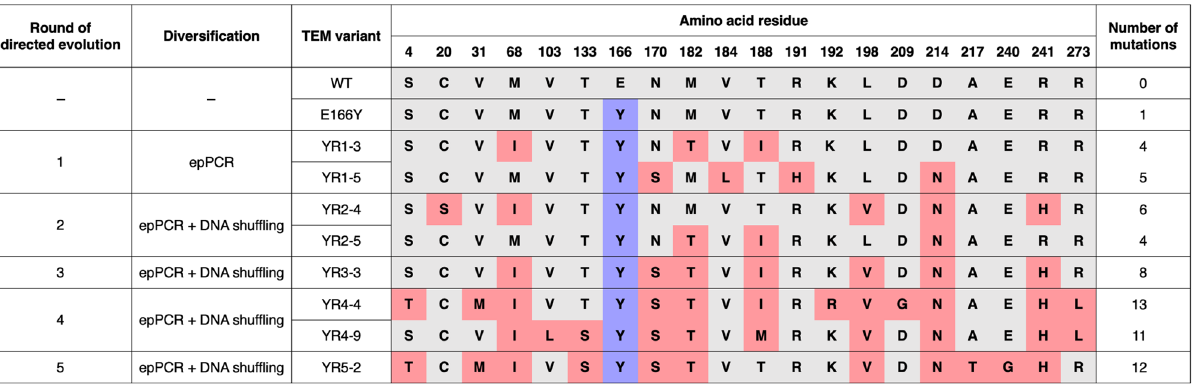
Table 2. Evolutionary information of the TEM variants. The E166Y mutation is highlighted in purple. Other mutations are highlighted in pink. Residue numbering is based on the Ambler numbering scheme 35 .